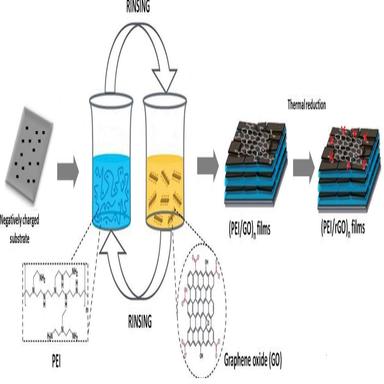
Schematic representation of the LbL assembly of reduced graphene oxide multilayer with PEI.